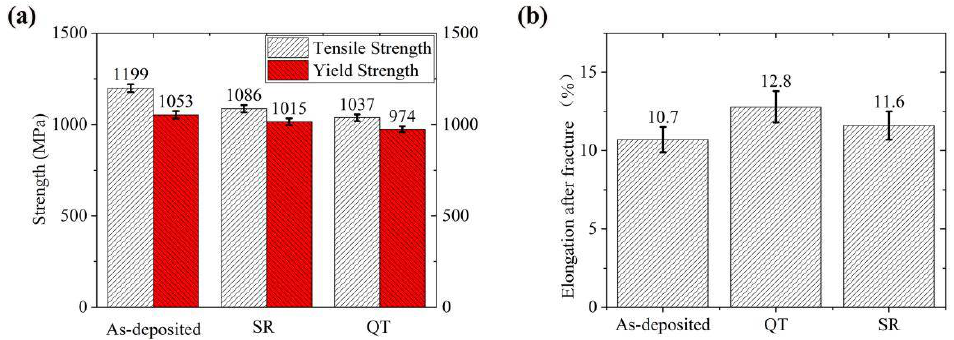
Figure 10. Tensile test results: ( a ) tensile strength and yield strength; ( b ) elongation after fracture.